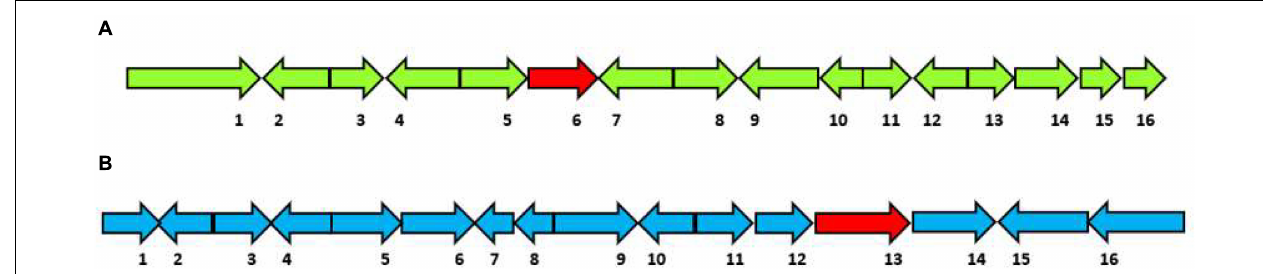
FIGURE 5 | Schematic illustration of the organization of the putative biosynthetic gene clusters for both HfasTerp-147 and HfasTerp-104. (A) The extended HfasTerp-147 biosynthetic gene cluster. 1 = Complex I intermediate-associated protein; 2 = Protein binding; 3 = F-box; 4 = Histone methyltransferase; 5 = RNA polymerase; 6 = Terpene synthase; 7 = Cystathionine beta-lyase; 8 = Pyruvate carboxyltransferase; 9 = Dolichol kinase; 10 = Zinc finger; 11 = Splicing factor; 12 = Proliferation-associated protein; 13 = Chaperone regulator; 14 = Enoyl-CoA hydratase; 15 = Aspartic peptidase; 16 = Aspartic peptidase. (B) Organization of the putative biosynthetic gene cluster likely responsible in producing 3,5-dichloro-4-methoxybenzoic acid (3,5-D) in both Hypholoma fasciculare and the homologous cluster of Hypholoma sublateritium . 1 = Glycoside; 2 = Glutathione S-transferase; 3 = Anchor protein; 4 = Oxoprolinase; 5 = Monocarboxylate; 6 = Glycoside hydrolase; 7 = F-box; 8 = Anchor protein; 9 = Hypothetical protein; 10 = SDR; 11 = Calmodulin-related protein; 12 = Hypothetical protein; 13 = Terpene synthase; 14 = Regulator of G protein signaling; 15 = Benzoic acid reductase-PKS; 16 = 3-Phosphoshikimate-1-carboxyvinyltransferase.